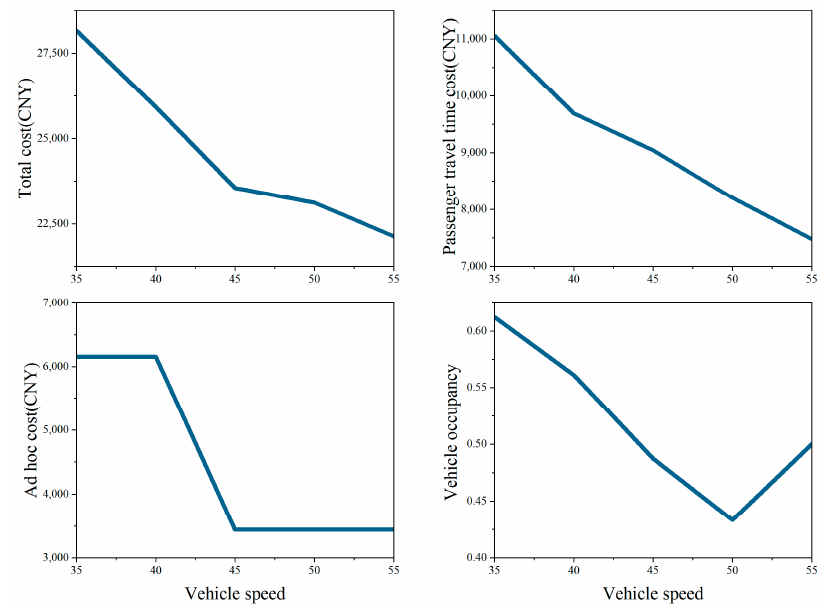
Figure 8. Sensitivity analysis of vehicle speed.